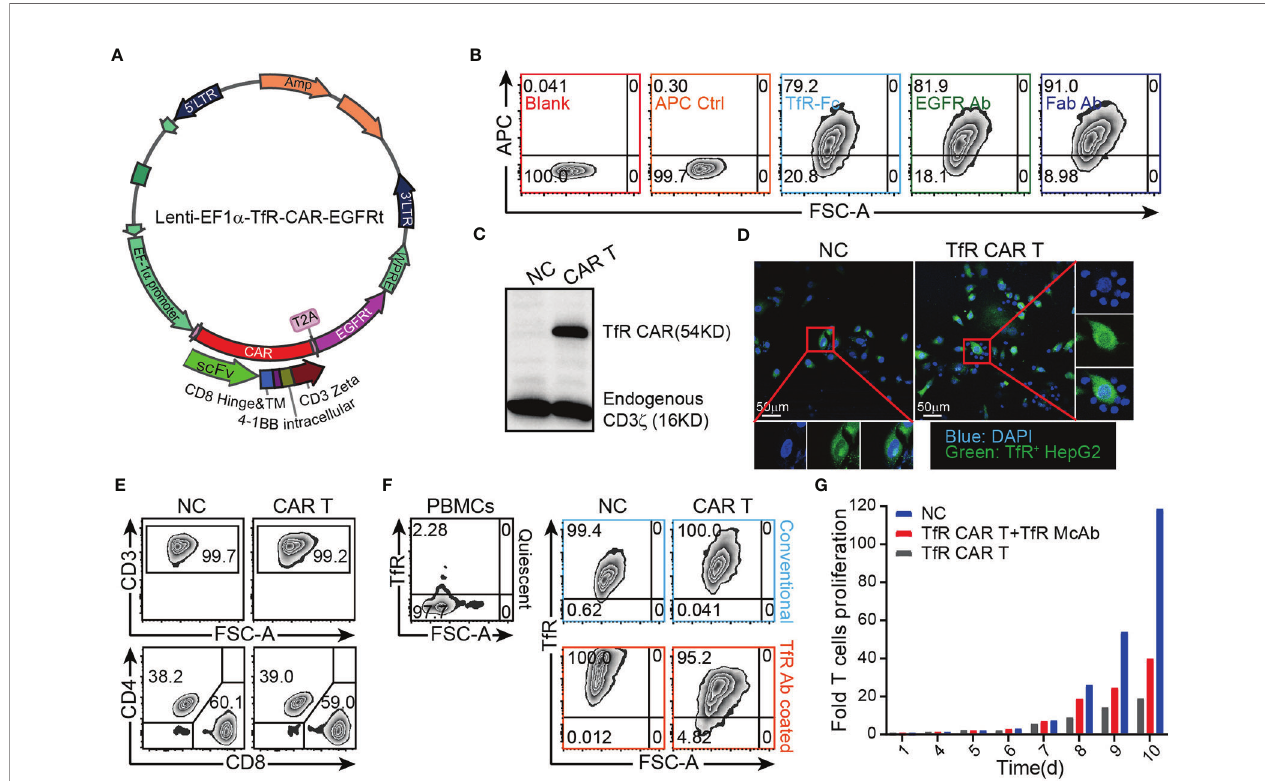
FIGURE 1 | Design and establishment of TfR-directed CAR (TfR-CAR) T cells. (A) Schematic representation of the TfR-CAR lentivirus plasmid. The TfR-CAR expression cassette was under the regulation of EF1 a promoter, and consisted of the hIL-2 signal peptide, anti-TfR scFv, the CD8 hinge and transmembrane region, and 4-1BB intracellular signaling domains, fused to the cytoplasmic region of the CD3 z chain. A truncated human EGFR (EGFRt) transduction marker was separated with T2A. (B) FCM analysis showing TfR-CAR expression. TfR-CAR T cells were stained respectively with TfR-hFc, Cetuximab, anti-F(ab ′ ) 2 fragment. APC control described the CAR T cells were only stained with secondary antibody, but no TfR-Fc or Cetuximab. (C) Western blot analysis showing TfR-CAR expression. Whole cell lysates were hybridized with anti-hCD3 z and HRP-conjugated goat anti-rabbit IgG. Molecular weight of the endogenous CD3 z chain: 16 kDa; predicted molecular weight of the TfR-CAR: 54 kDa. (D) TfR-CAR T cells recognized and linked the TfR + HepG2 cells. CFSE pre-stained HepG2 cells were incubated with TfR-CAR T cells or NC T cells for 90 min. Then cells were fi xed and stained with DAPI. Rosette formation were detected by a confocal microscope. (E) The percentages of CD3 + cells and CD4 + /CD8 + subsets in TfR-CAR T cells and NC T cells. (F) TfR expression on quiescent PBMCs and expanded T cells. Upper panel black signage: Quiescent PBMCs showed very low TfR expression. Upper panel blue signage: Expanded T cells cultured in conventional methods. Under panel orange signage: Expanded T cells cultured in anti-TfR mAb coated plates. (G) Expansion of TfR-CAR T cells. Transduced T cells were cultured in media supplemented with IL-2 (30 IU/mL) in plates coated with (red signage) or without (gray signage) anti-TfR mAb. Cell counts were recorded every day and fold cell expansion was